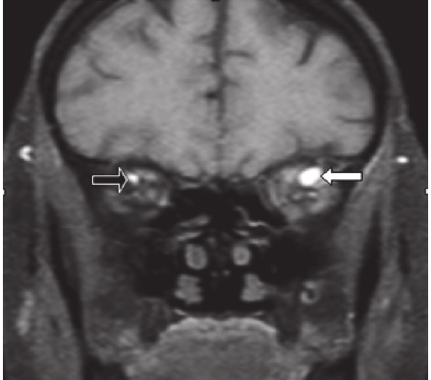
Figure 2: Axial T1-weighed magnetic resonance imaging with contrast demonstrating a greatly dilated left superior ophthalmic vein(whitearrow)andnormalrightsuperiorophthalmicvein(black